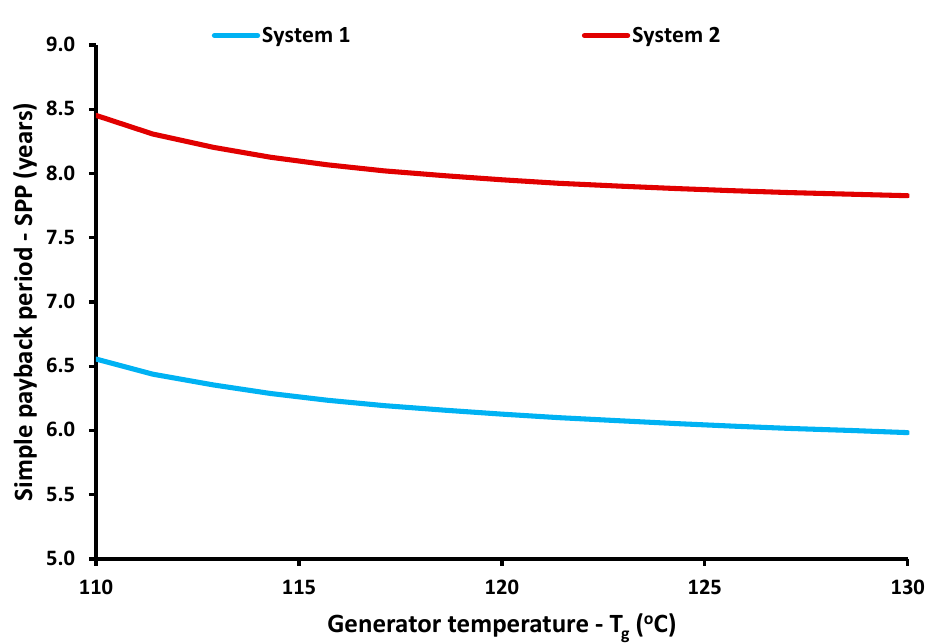
5.05.56.06.57.07.58.08.59.0 Figure 8. Simple payback period for the three systems with different values of the generator temperature level. Figure 9. Energy and exergy efficiency for the three systems with different values of the generator temperature level.